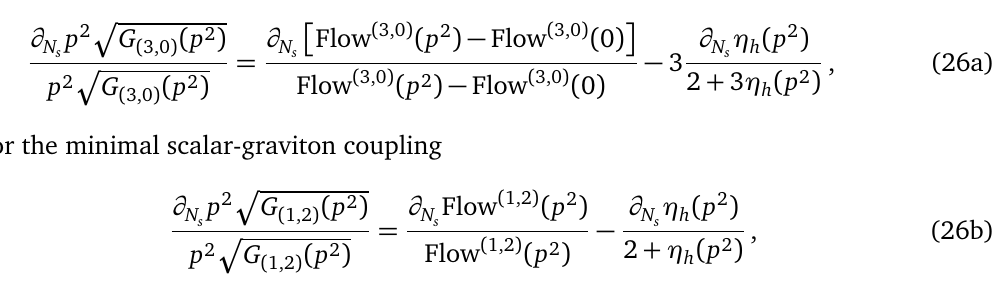
Fig.2. Accordingly, scalars only change the system qualitatively for N in Fig. 1: the system is basically unchanged for N